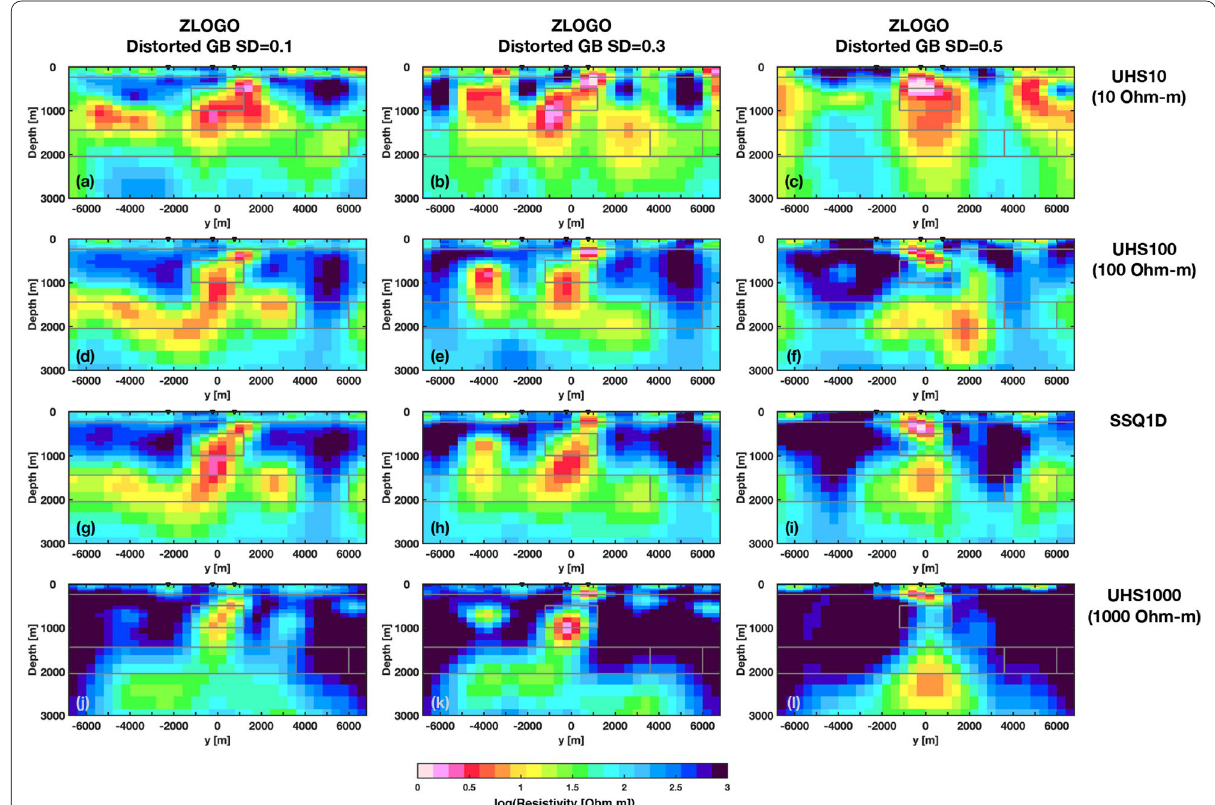
Fig. 11 Data RMS misfits and the model recovery factors for different initial (prior) models obtained from inverting a all elements (ZLOGA) and b off‑diagonal elements (ZLOGO) of the distorted MT impedance tensor. Orange, red, and blue curves correspond to three different levels of distortion, as represented by SD 0.1, 0.3, and 0.5, respectively =